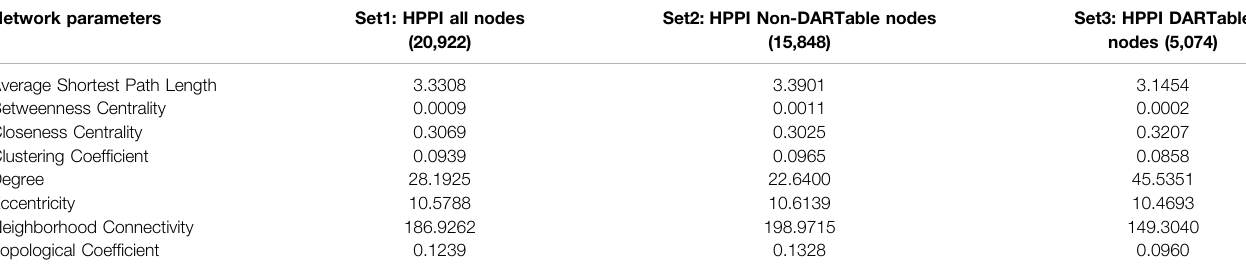
TABLE 2 | Topological properties of nodes in the network. Table 2 shows the average calculated topological properties of each node in the network. Three sets of nodes were determined: Set1: all nodes in HPPI, Set2: only nodes that are non-DARTable genes (nodes that are not part of HDG) and Set3: only nodes that are DARTable genes (analogically, nodes that are part of HDG). Value in brackets indicates number of nodes in each